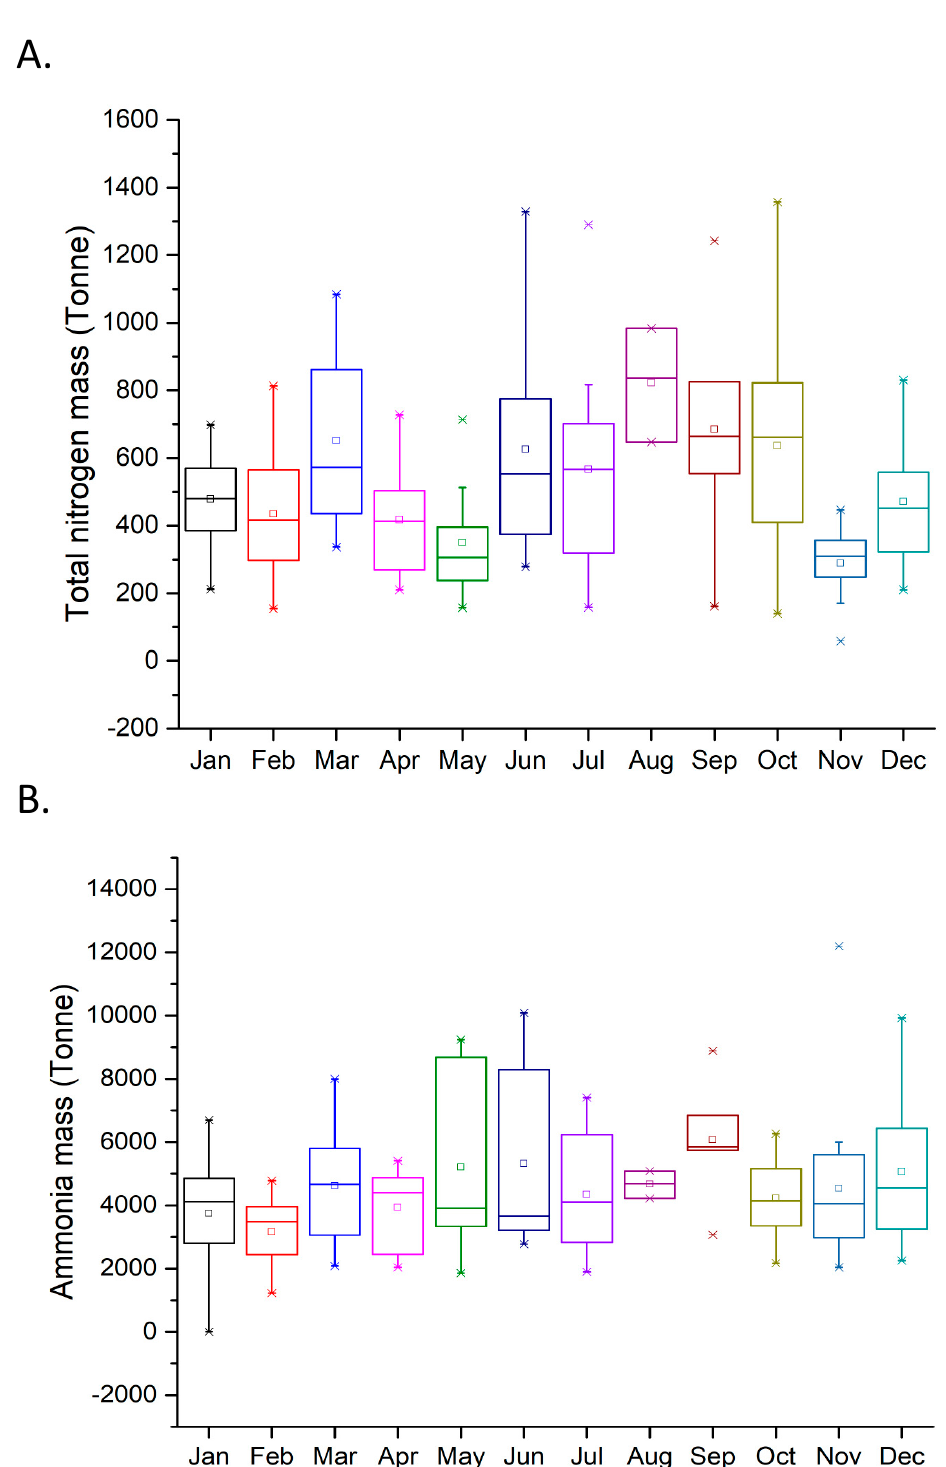
Figure 3. Monthly average concentrations for COD, NH 3 , TN and DO in RCWW.